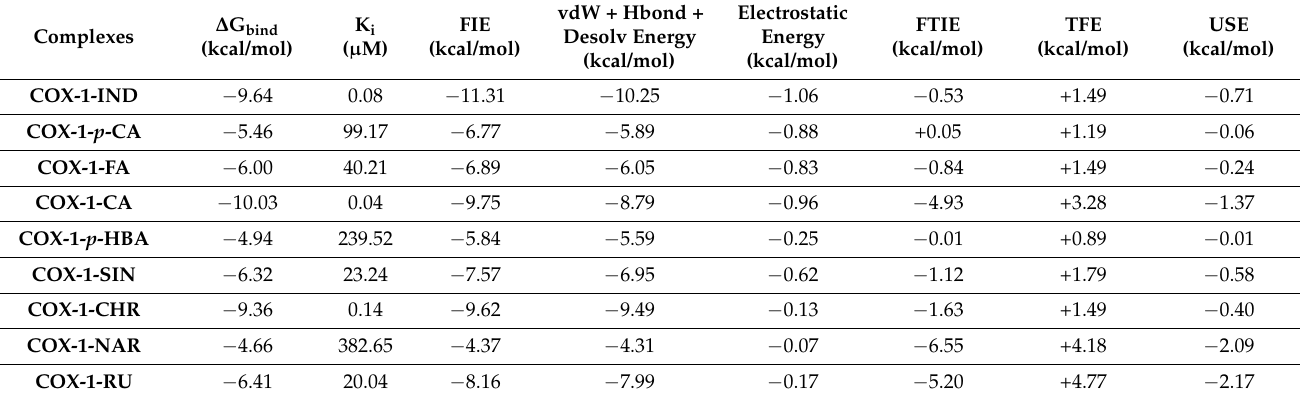
Table 5. Important thermodynamical parameters from docking simulations between indomethacin (IND), selected compounds p -coumaric acid ( p -CA), ferulic acid (FA), chlorogenic acid (CA), p - hydroxybenzoic acid ( p -HBA), sinapic acid (SIN), chrysoeriol (CHR), naringin (NAR), and rutin (RU) with COX-1.